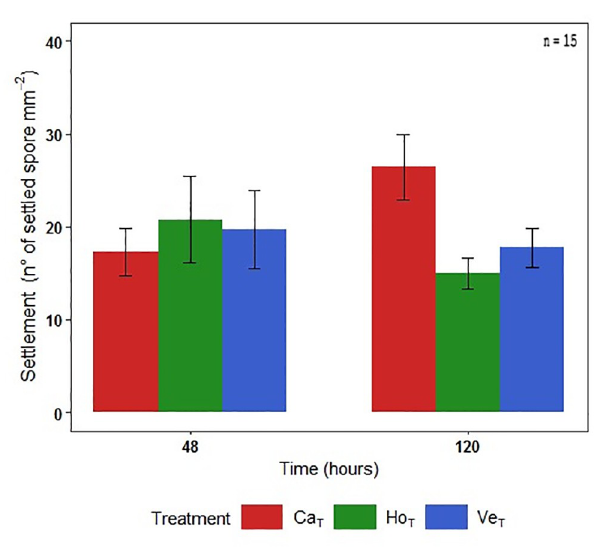
Fig 6. Settlement. Number of settled spores of Lessonia spicata per treatment showing SD (n = 15), at 48 and 120 h of exposure.